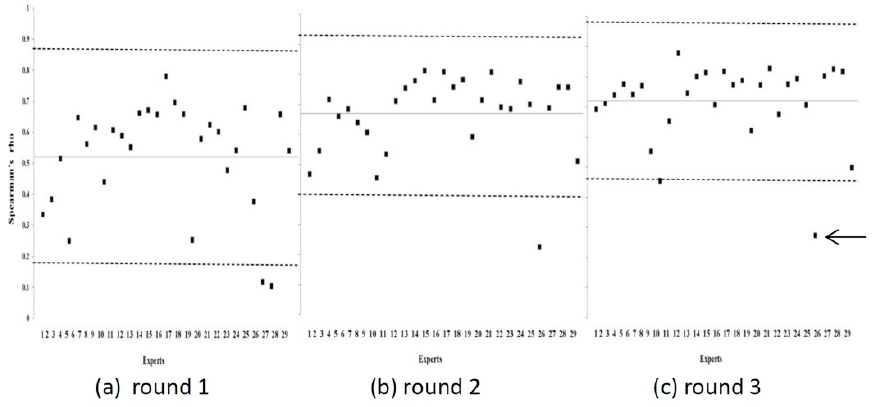
Figure 1. Spearman’s ρ values between each individual expert score and the group mean score of all experts over three rounds of Delphi exercises. The horizontal solid line indicates the mean value of Spearman’s ρ in each round. The area between the dotted lines indicates the mean ±1 standard deviation. Differences between the mean Spearman’s ρ of each round were significant (Wilcoxon signed ranks test, Round 1 vs. Round 2, p < 0.001; Round 2 vs. Round 3, p < 0.05; Round 1 vs. Round 3, p < 0.001). Because Spearman’s ρ for Expert 25 (arrow) was lower than 0.4 in the third round, that data point was regarded as an outlier.